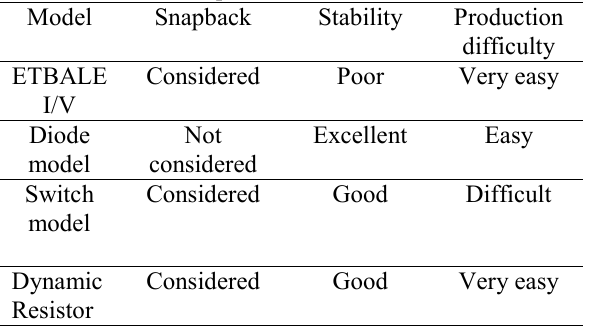
Table 1: Synthesis of models characteristics and